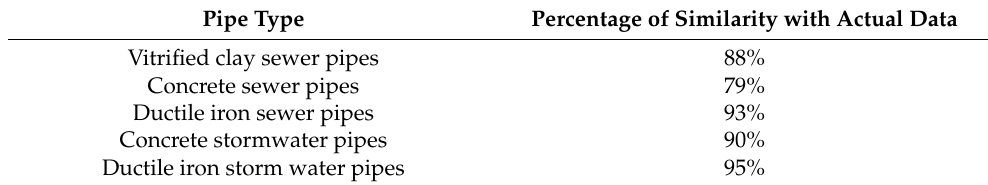
Table 1. Similarity percentage of unsupervised model result with the actual data.